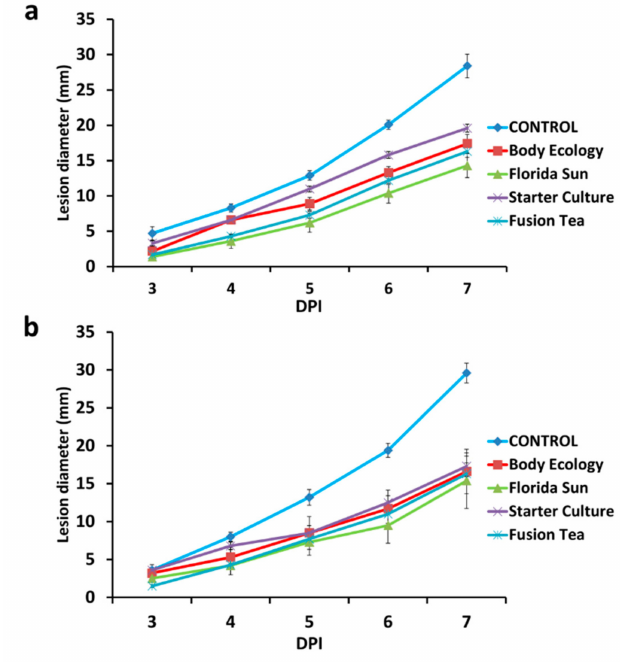
Figure 5. E ff ect of application of kefir grains as fresh ( a ) or milk-activated ( b ) on decay severity (lesion diameter of the wounds) on apple. Fruit were treated with suspensions of kefir grains and inoculated 2 h later with Penicillium expansum (10 5 spores ml − 1 ) or 20 µ L sterile distilled water in control, and measurements were taken at 3, 4, 5, 6, and 7 days post inoculation (DPI). Bars indicate standard errors of the